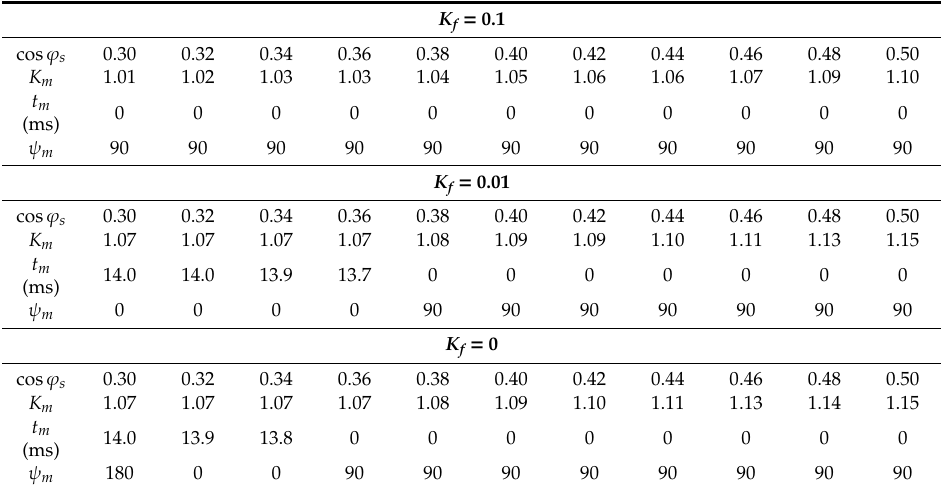
Table 4. The derivatives of start current with di ff erent load